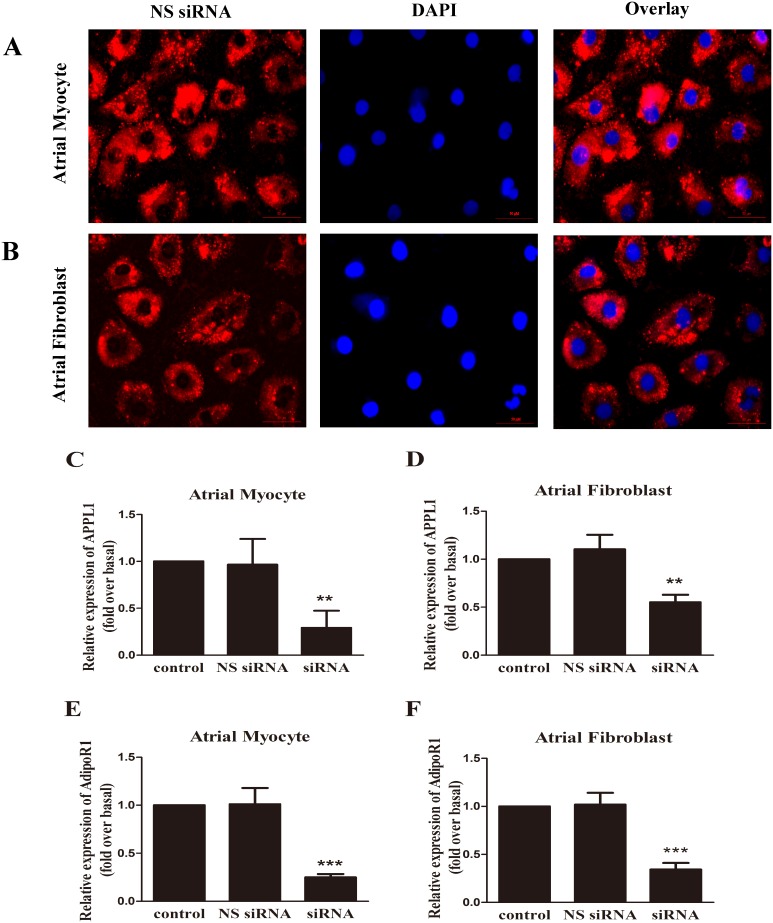
mRNA expression of APPL1 and AdipoR1 after transfection by specific siRNA in neonatal primary rat atrial myocytes and fibroblasts.(A) and (B) Fluorescence microscopy images showing the localization of the Cy3-tagged siRNA transfected atrial myocytes and fibroblasts for 24 h. The cell nuclei were stained with DAPI (blue). Scale bar, 50 µm. (C)–(F) Quantitative real time PCR analysis of the mRNA expression of APPL1 and AdipoR1 which was normalized by non-silencing (NS) siRNA. The concentration of siRNA was 100 nM appropriately. Data were expressed as mean ± SD of three independent experiments. **P<0.01; ***P<0.001 vs. nontransfected control.